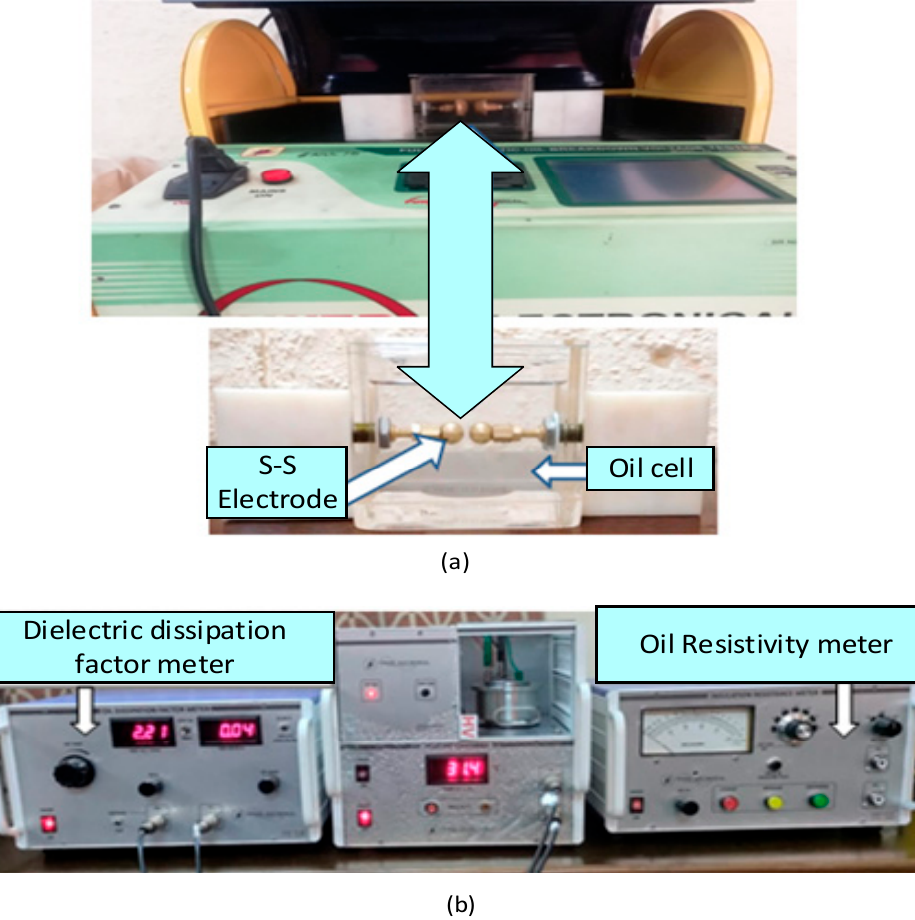
Figure 4. Experimental set-up to measure ( a ) AC Breakdown voltage of oils and ( b ) DC Resistivity and dielectric dissipation factor.